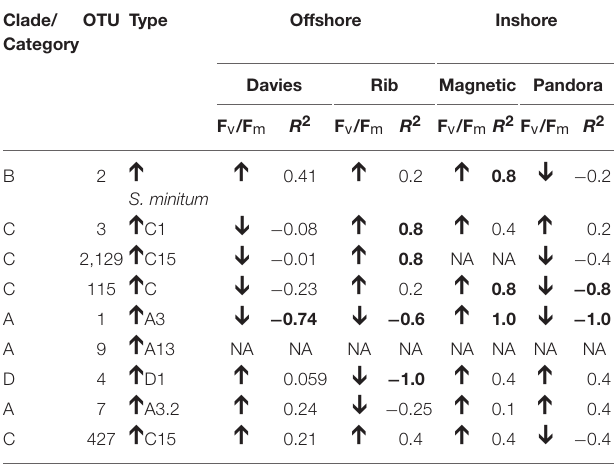
TABLE 2 | Spearman’s rho R 2 correlation coefficients calculated for each of the nine most highly abundant OTUs in juveniles compared to F v /F m values per site. Clade/ CategoryOTU Type Offshore Inshore